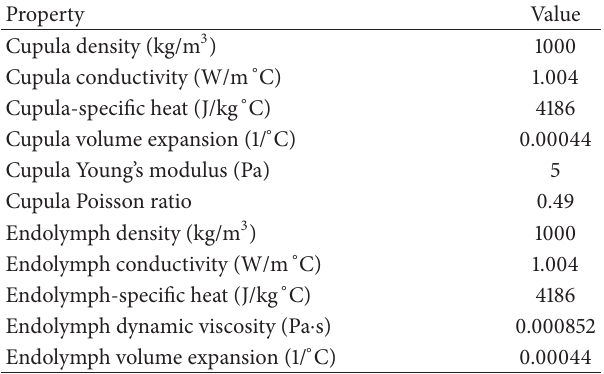
Table 1: The physical and structural properties of the endolymph and